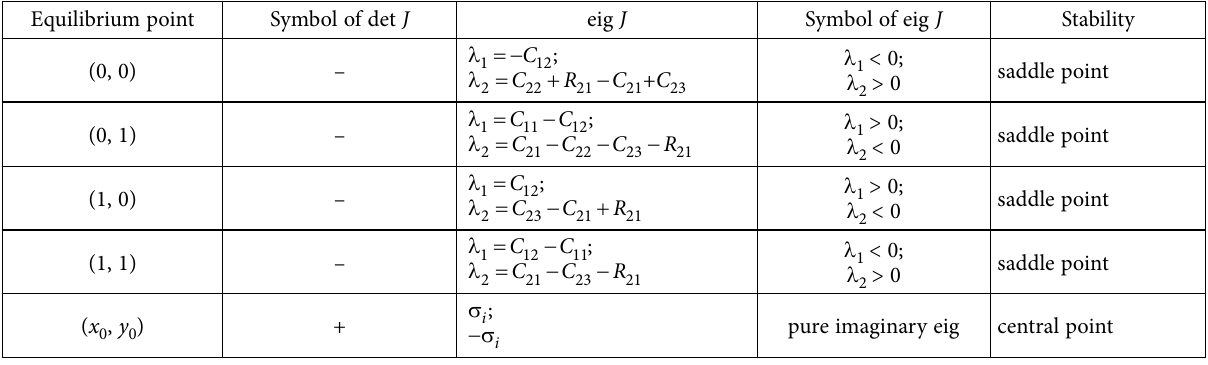
Table 4. The stability analysis of the evolutionary game based on Scenario 2 of Section